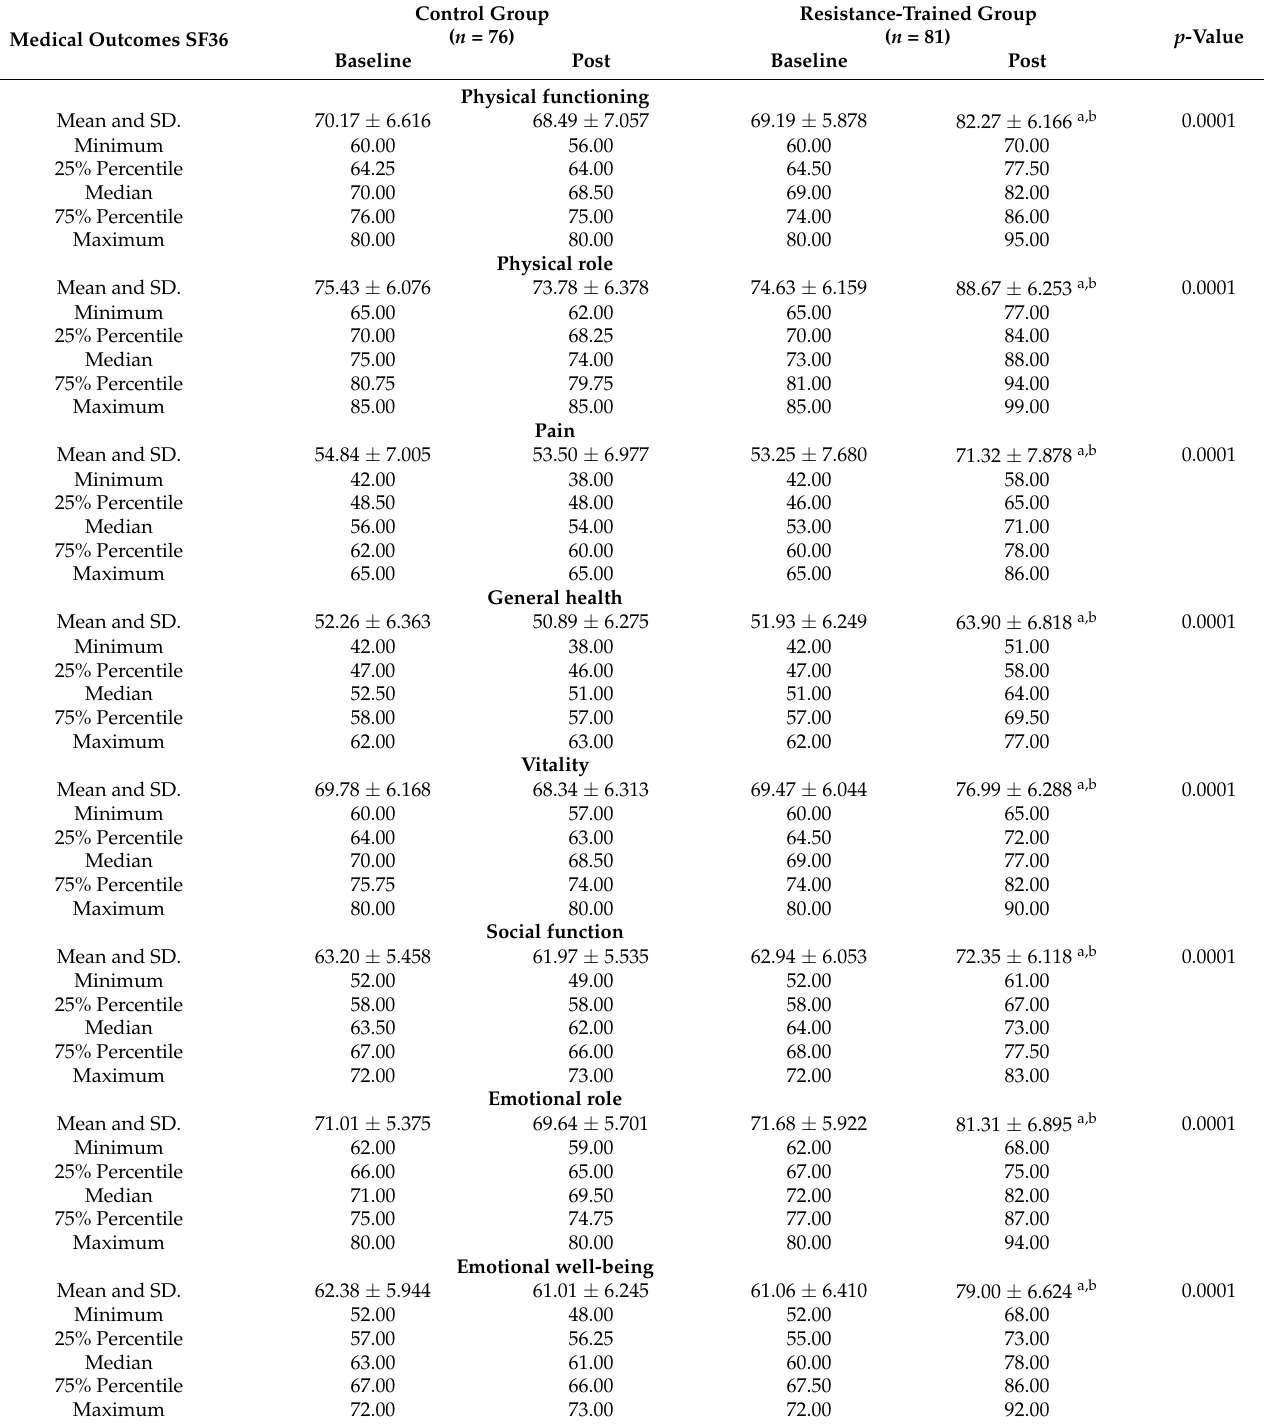
Table 4. Baseline and post-intervention Medical Outcomes Study—SF36 between control and resistance-trained group. Control Group Resistance-Trained Group ( n = 76) ( n = 81) p -Value Medical Outcomes SF36 Baseline Post